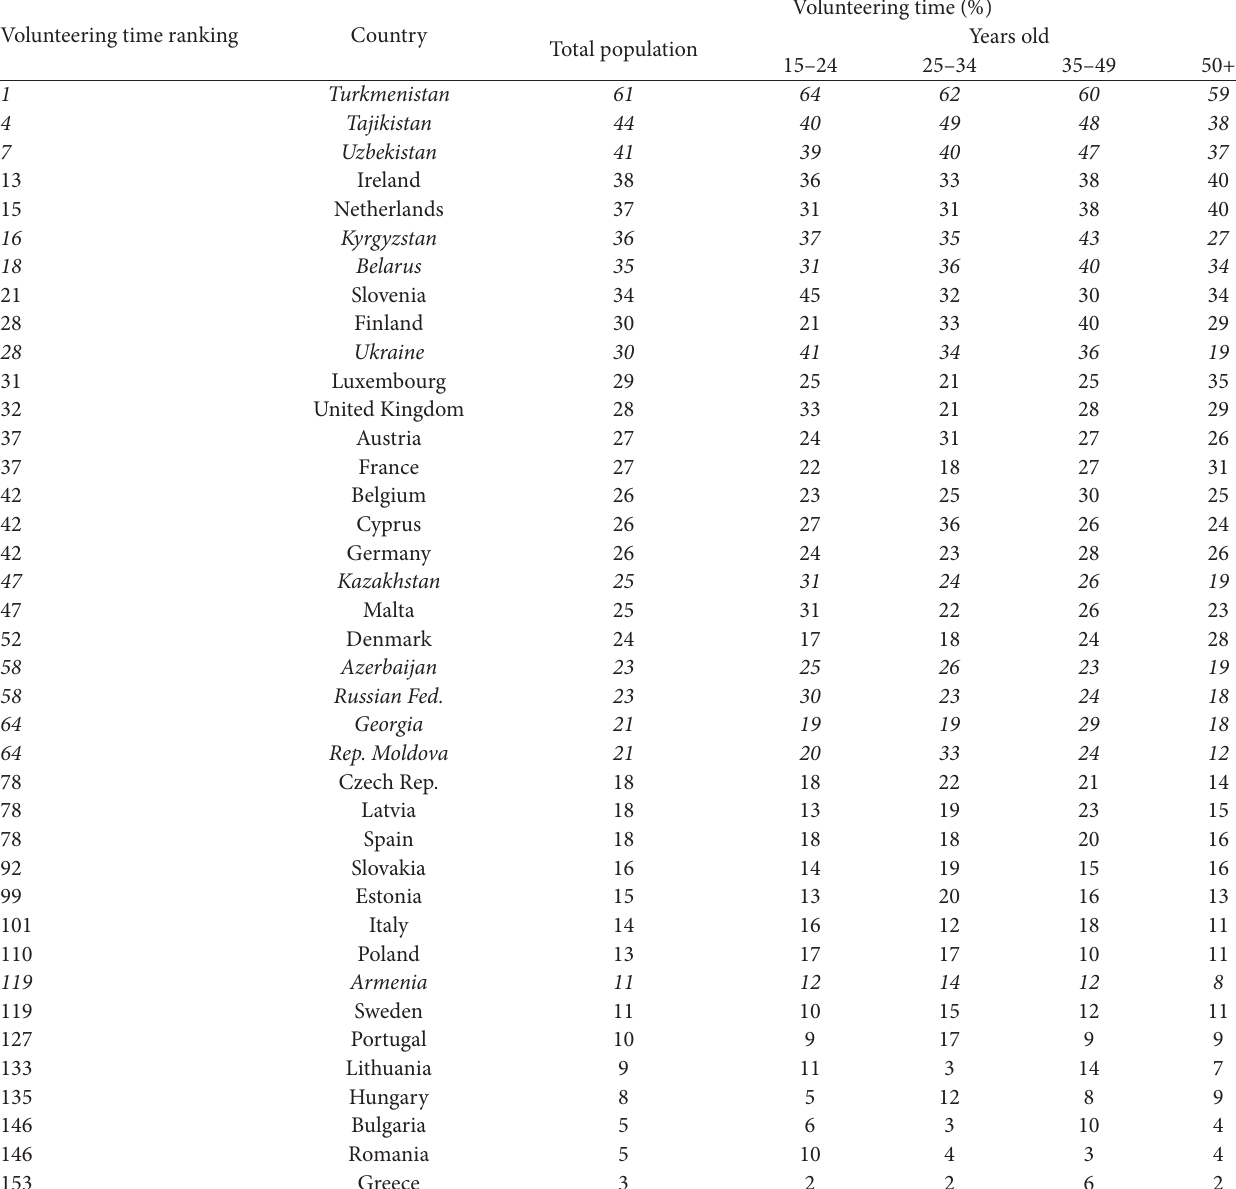
T 2: CIS and EU countries ranked by the percentage of population volunteering time,